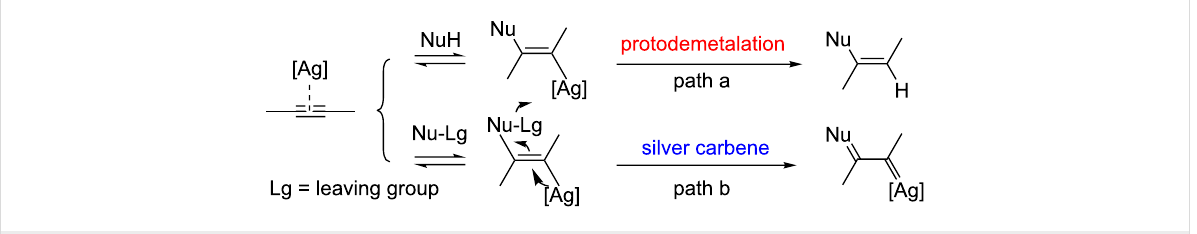
Scheme 1: Two modes of reactions of alkynes by silver catalysis.